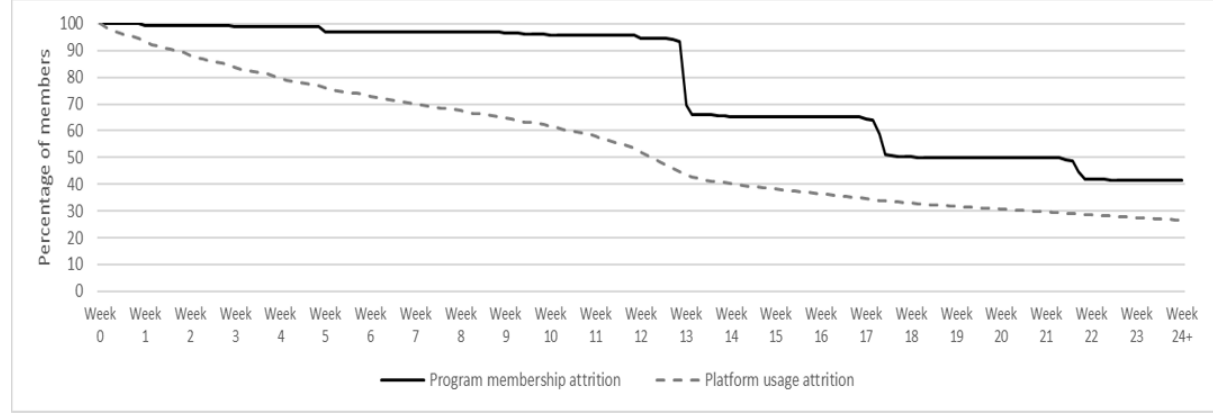
Figure 2. Program membership and platform usage attrition over 24 weeks for members of the CSIRO Total Wellbeing Diet Online